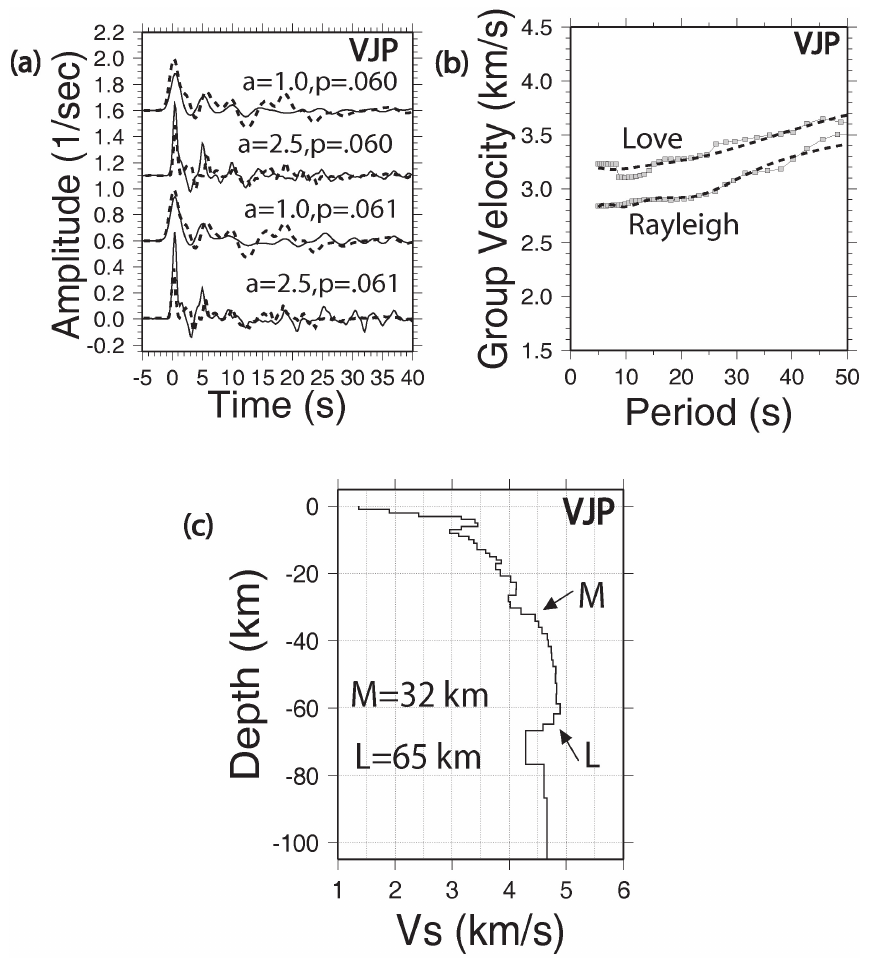
Fig. 4. (a) Estimation of crustal and lithospheric thickness at VJP seismic station using joint inversion of radial receiver functions and surface wave group velocity dispersion data (Julia et al., 2000). Correlation between the receiver functions obtained from observed data and joint inversion are shown by solid grey and dotted black lines, where, “a” and “p” represent the Gaussian width factor and horizontal slowness, respectively, which are used to compute receiver functions; (b) correlation between group velocity dispersion curves obtained from observed data (solid grey line with solid square symbols) and joint inversion (dotted black line); and (c) final model obtained from joint inversion. M represents the Moho and L represents the